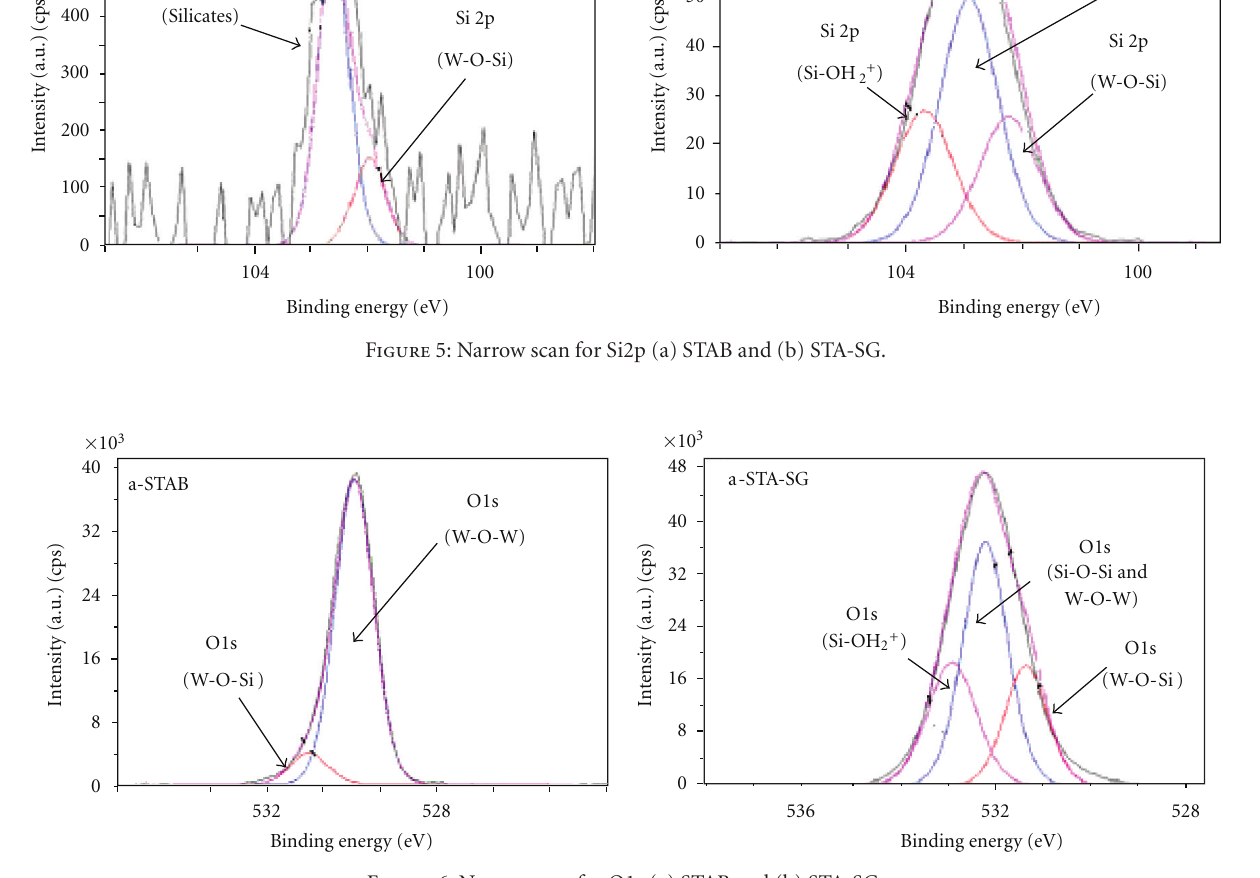
Figure 6: Narrow scan for O1s (a) STAB and (b) STA-SG.